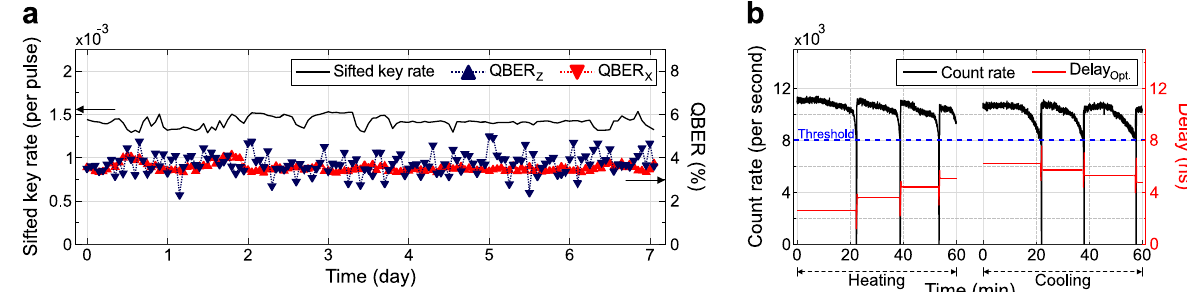
Fig. 7 Long-term stability of our experimental setup. a Sifted key rate and quantum bit error rates (QBERs) for a week. The stable sifted key rate and QBERs verify our system ’ s ability to compensate for the environmental change. b Single-photon count rate (count per second) and optimal gate delay when heating and cooling the quantum channel (QC) and storage line (SL) between 22 °C and 60 °C. It shows that the timing calibration system can cope with the rapid temperature